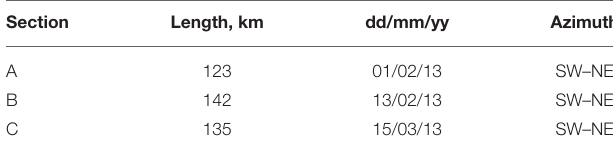
TABLE 1 | Seismic acquisition information ( Figure 1